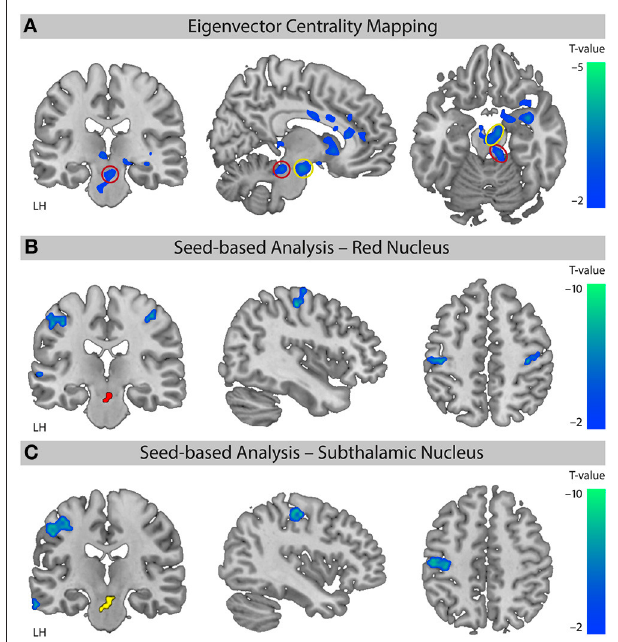
FIGURE 3 | Comparison of the two stimulation conditions. Effect on functional connectivity for the contrast [XNKQ vs. “non-acupuncture point with stimulation” (npws)]. (A) Data-driven ECM analysis shows decreased centrality for XNKQ, mainly in subcortical regions. Monte Carlo simulation with AlphaSim was used to identify significant clusters at pFWE < 0.05 (family-wise error (FWE) correction for multiple comparisons). Red circle (Red Nucleus) and yellow circle (Subthalamic Nucleus) indicate areas that were used for seed-based correlation analyses. MNI slice coordinates X = – 8, Y = – 22, Z = – 18. (B) Seed-based functional connectivity with seed in Red Nucleus. Whole brain analysis shows for XNKQ decreased temporal correlation of the seed-region (red) with primary sensorimotor areas (voxel-wise FWE correction at pFWE < 0.05). MNI slice coordinates X = 41, Y = – 22, Z = 51. (C) Seed-based functional connectivity with seed in Subthalamic Nucleus. Whole brain analysis shows for XNKQ decreased temporal correlation of the seed-region (yellow) with left primary sensorimotor areas (voxel-wise FWE correction at pFWE < 0.05). MNI slice coordinates X = – 40, Y = – 20, Z = 48. LH, left